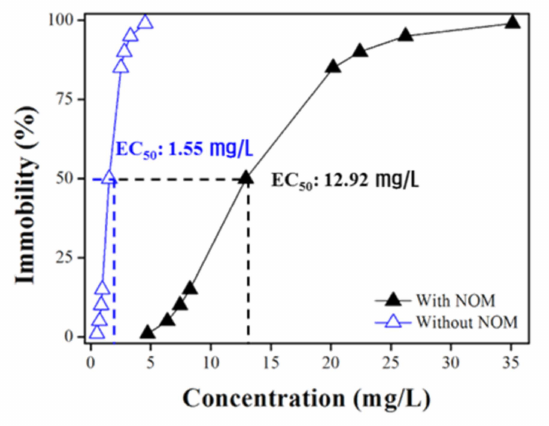
Figure 8. Daphnia magna immobility by ZnO NPs with / without